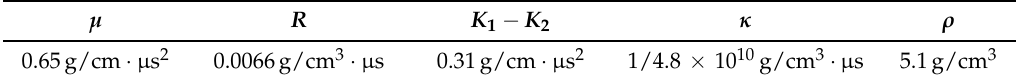
Table 2. The related parameters used in numerical computation [16,17,21,69,70].